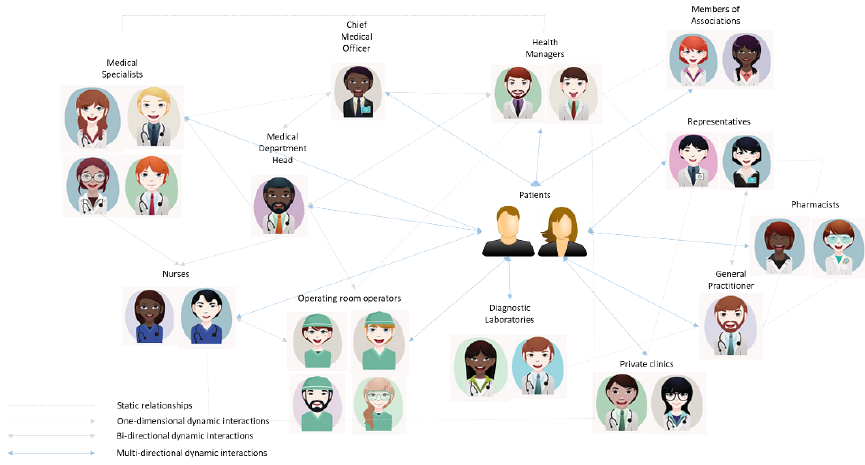
Fig.2. Configuring today multi-level HSES